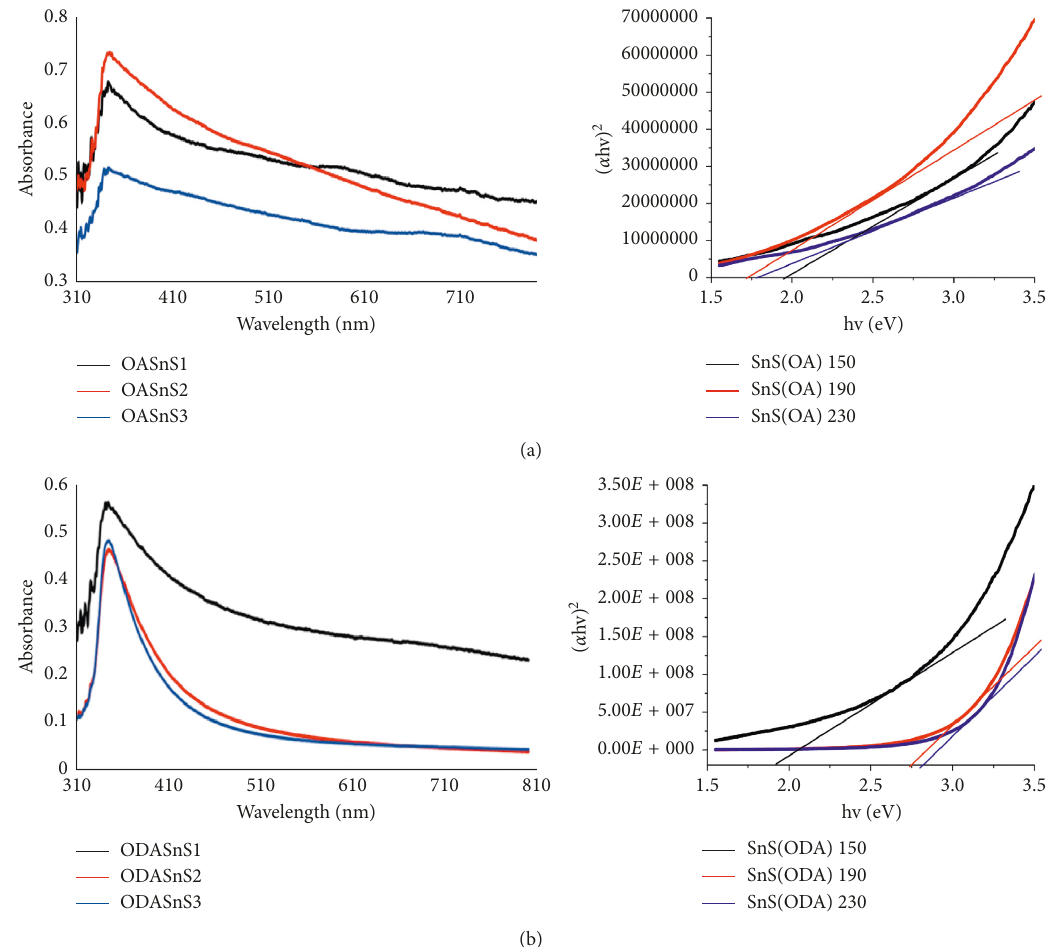
Figure 5: UV-Vis absorption spectra of OASnS with its Tauc plot (a) and ODASnS with its Tauc plot